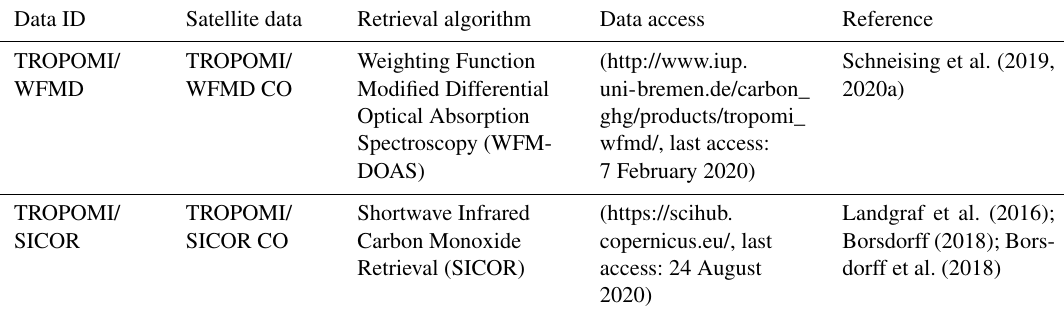
Table 1. Overview of the TROPOMI CO products used in this